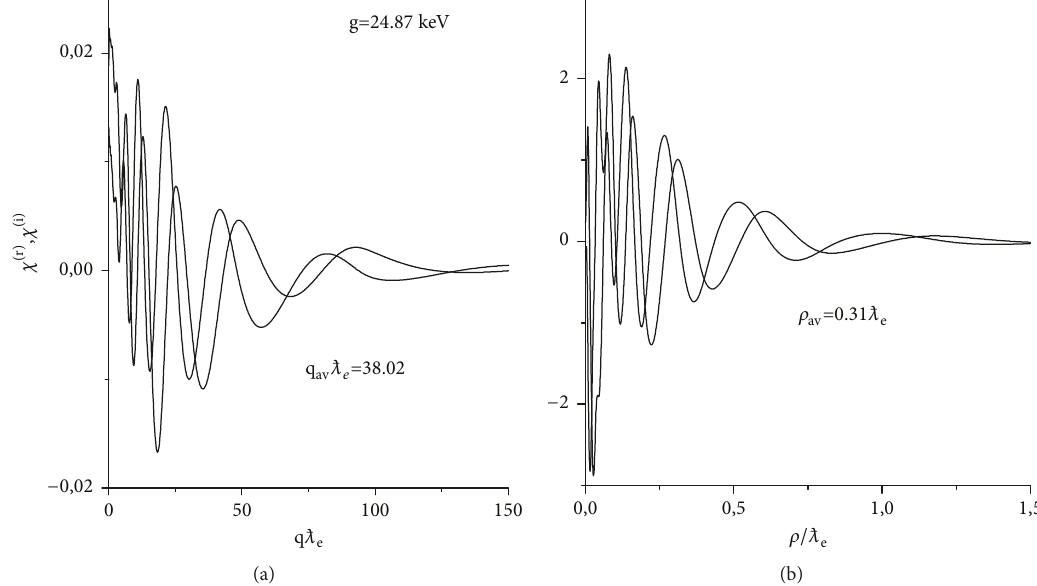
Figure 4: The massless boson wave function in the momentum space (a) and the coordinate space (b) for the kinetic energy 24.87 keV. The parameter 𝑓 0 = 767